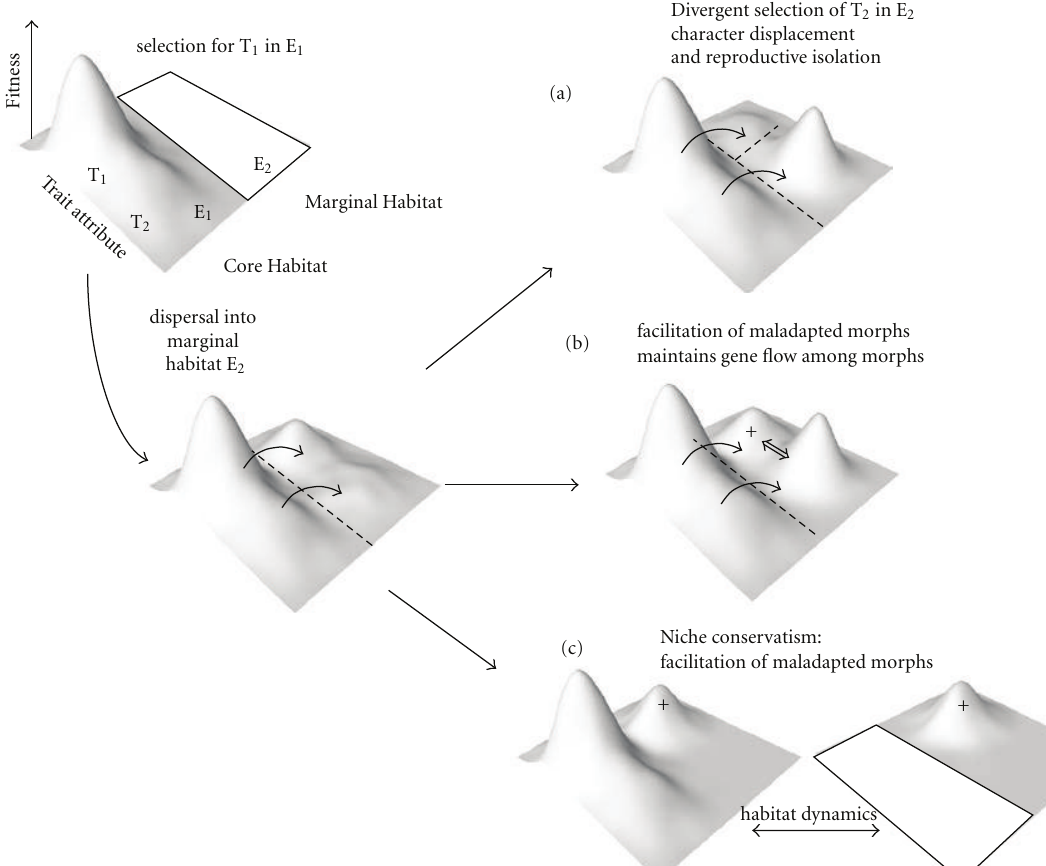
Figure 1: How facilitation may interfere with ecological speciation and niche conservatism. These 3D plots sketch ongoing disruptive selection and trait divergence of incipient species. The vertical axis represents the relative fitness of genotypes in a trait-ecological space. We assumed that ecologically marginal conditions (E2) also correspond to peripheral areas. Solid arrows are for gene flow including dispersal of propagules, individuals, and sexual reproduction. Dotted lines denote reproductive isolation. A common starting point is immigration of genotypes from the favorable part of the gradient to marginal/peripheral habitats. (a) Diversifying selection without facilitation, and reproductive isolation that eventually arises as a by-product of trait divergence. (b) Maladapted forms persist in marginal habitats because of facilitation and a maintained gene flow among genotypes prevents ecological speciation. (c) Facilitation allows maladapted forms to persist in a changing environment, that is, niche